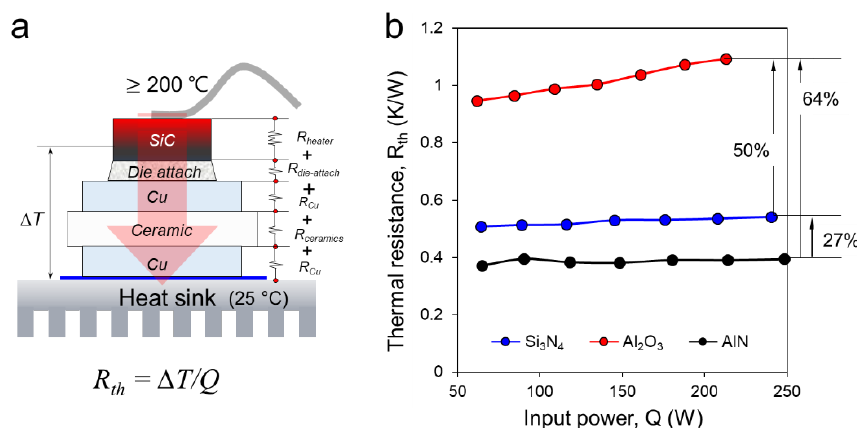
Figure 6. ( a ) Schematic diagram of heat path and its thermal resistance measurement during power cycling ( b ) results of various ceramics of thermal resistance.